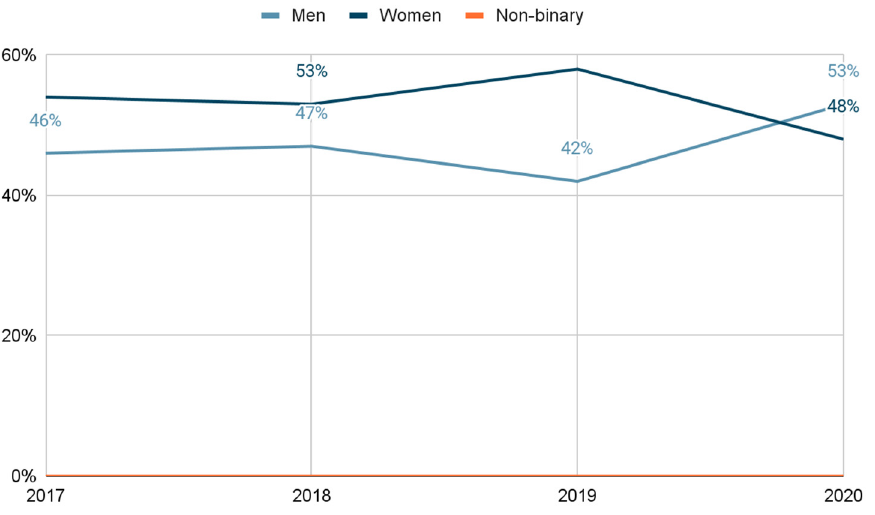
Figure 9. Gender of the accounts that the sample of Spanish deputies started to follow in 2017, 2018, 2019 and 2020.